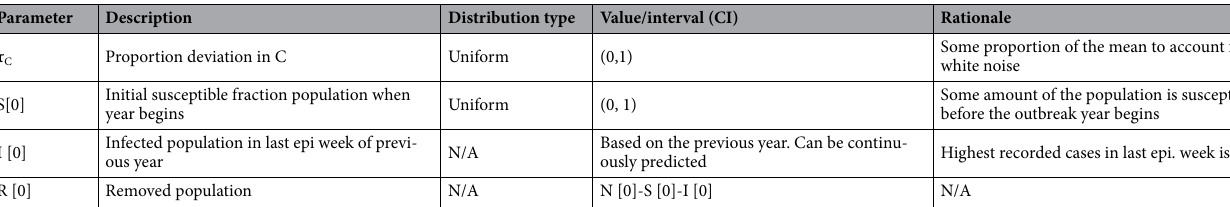
Table 9. The parameters of the SIR model that add stochasticity and the distributions these were sampled. epi. Epidemiological, N/A not